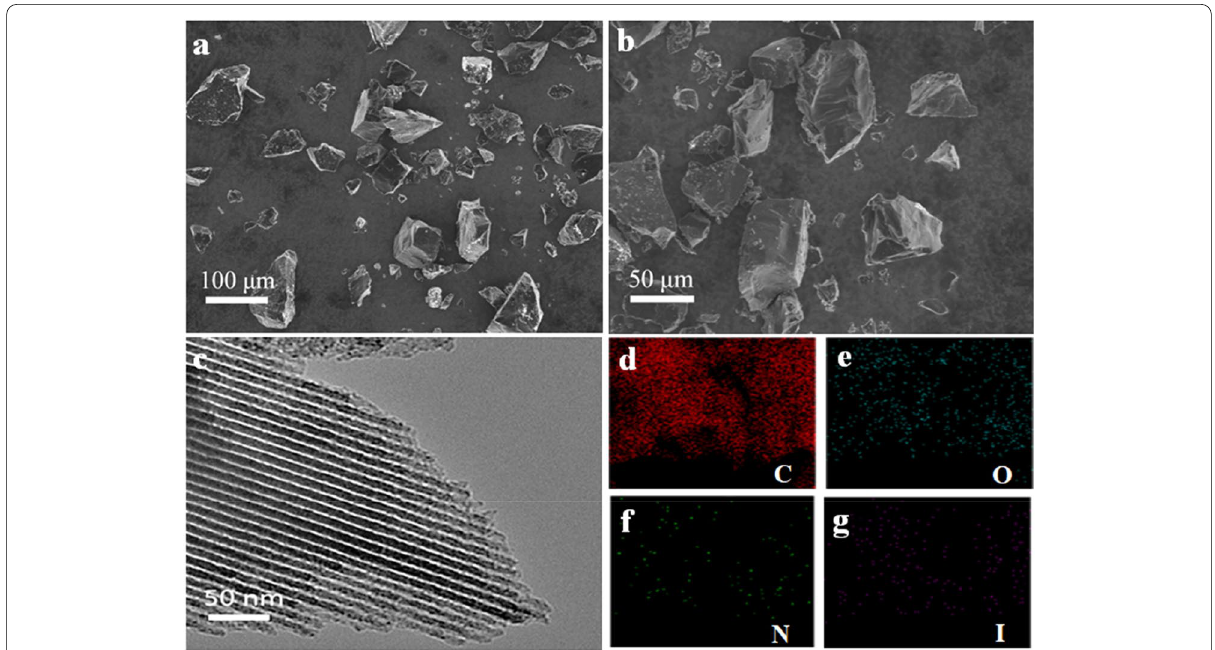
Fig. 3 SEM images of a FDU-15-600 and b 15%PIL-90@FDU-15-600. c TEM image of 15%PIL-90@FDU-15-600 and d - g corresponding elemental mapping images of C, O, N, and I,